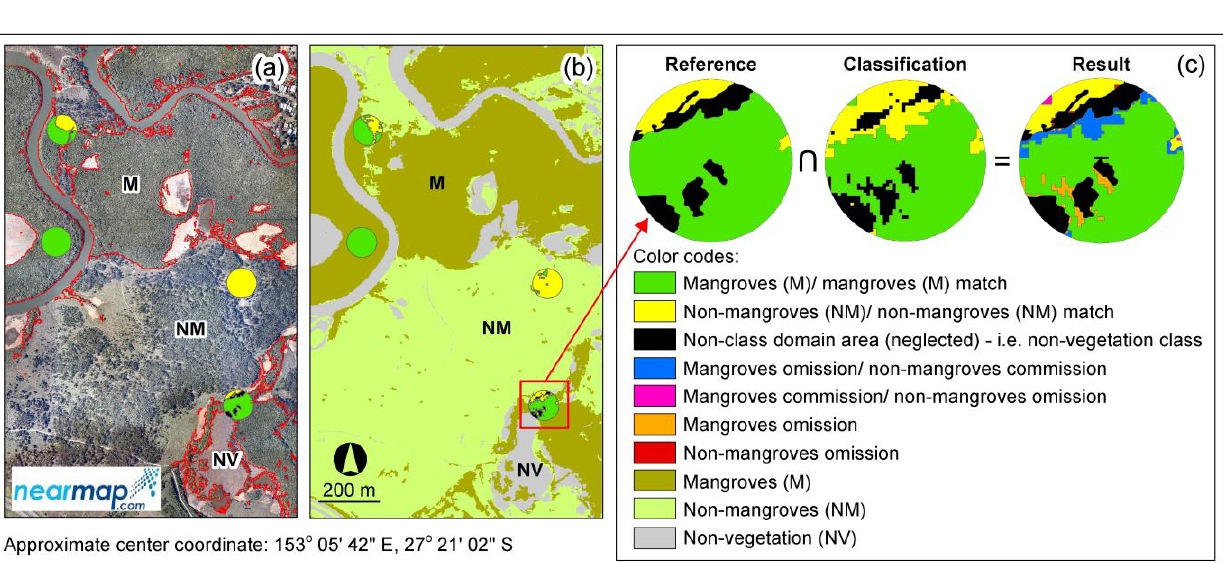
Figure 7. Example of mangroves and non-mangroves area-based accuracy assessment; ( a ) reference map, ( b ) classified map from WV-2 image, and ( c ) classes produced from area intersection